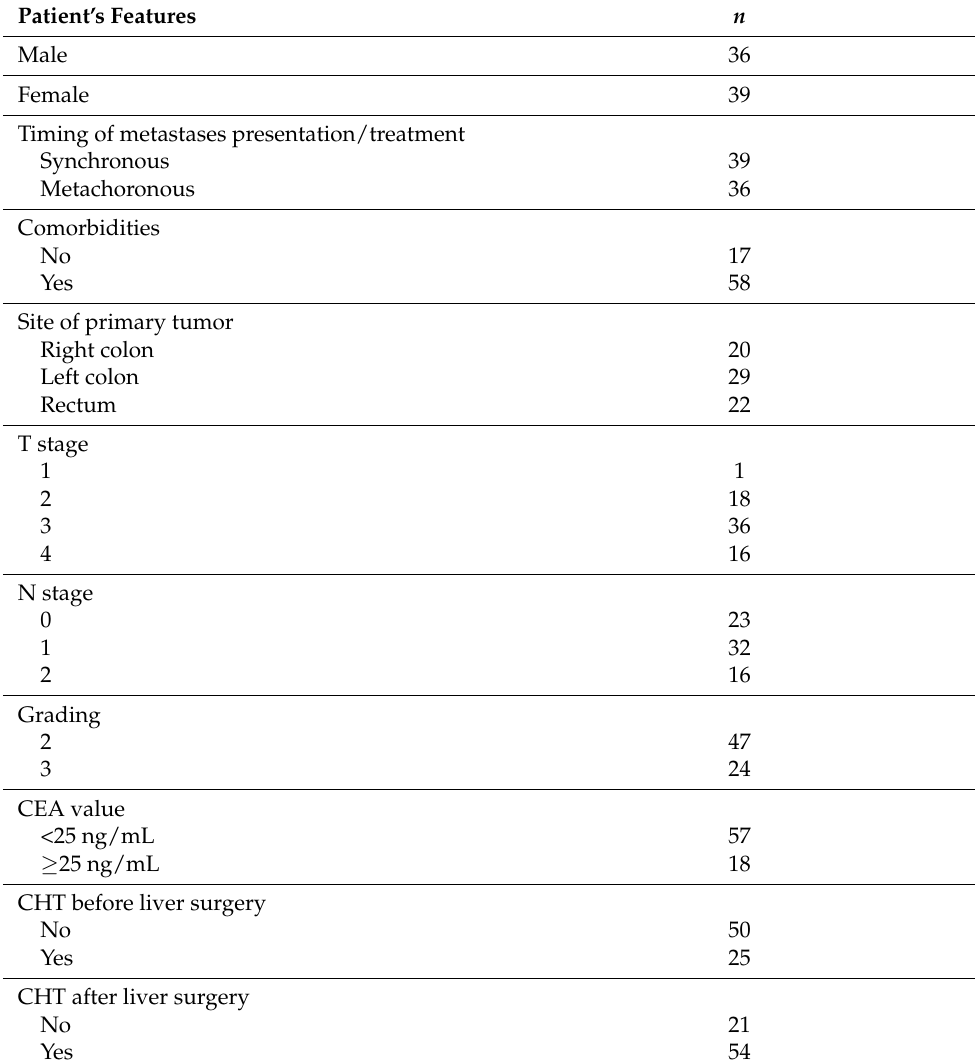
Table 1. Characteristics of the